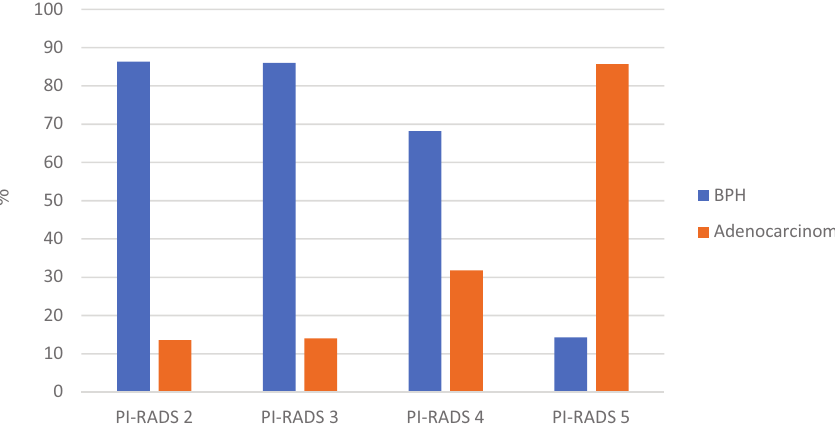
Figure 1. The distribution of Mp-MRI PI-RADS classification and the biopsy results. Mp-MRI, multiparametric magnetic resonance imaging; PI-RADS, prostate imaging reporting and data system. Table 4. The Distribution of Gleason Scores of the Patients with Adenocarcinoma Gleason